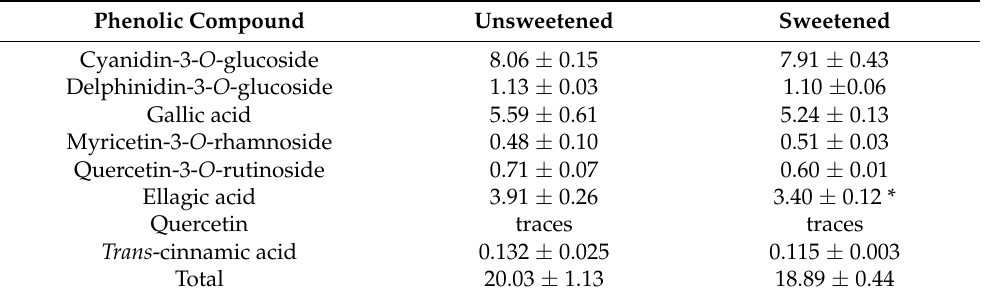
Table 2. Phenolic compounds contents (mg/100 mL) of unsweetened and sweetened jaboticaba juices.